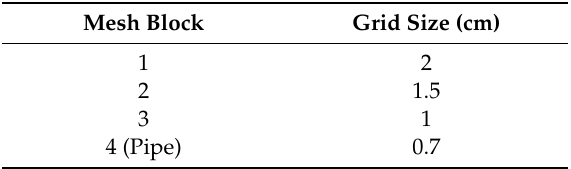
Table 9. Grid sizes in each mesh block in the